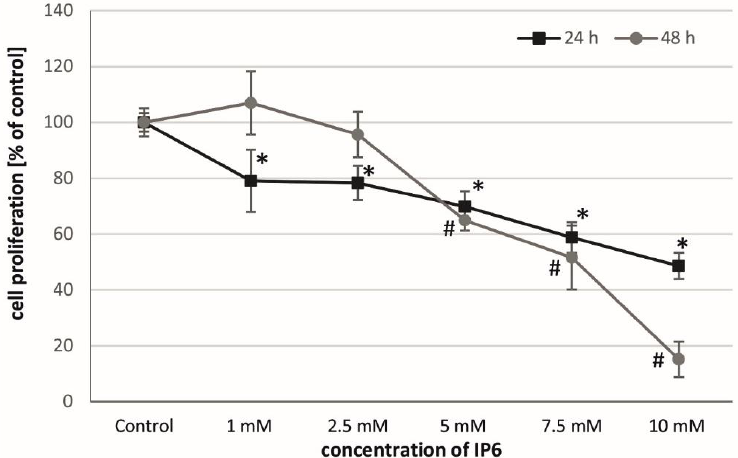
Figure 1. Proliferation cell inhibitory effect of InsP6 at various concentrations on Caco-2 cells after 24 and 48 h treatment. The results are expressed as percentage of untreated control (the means ± SD; * p < 0.05 vs. control).